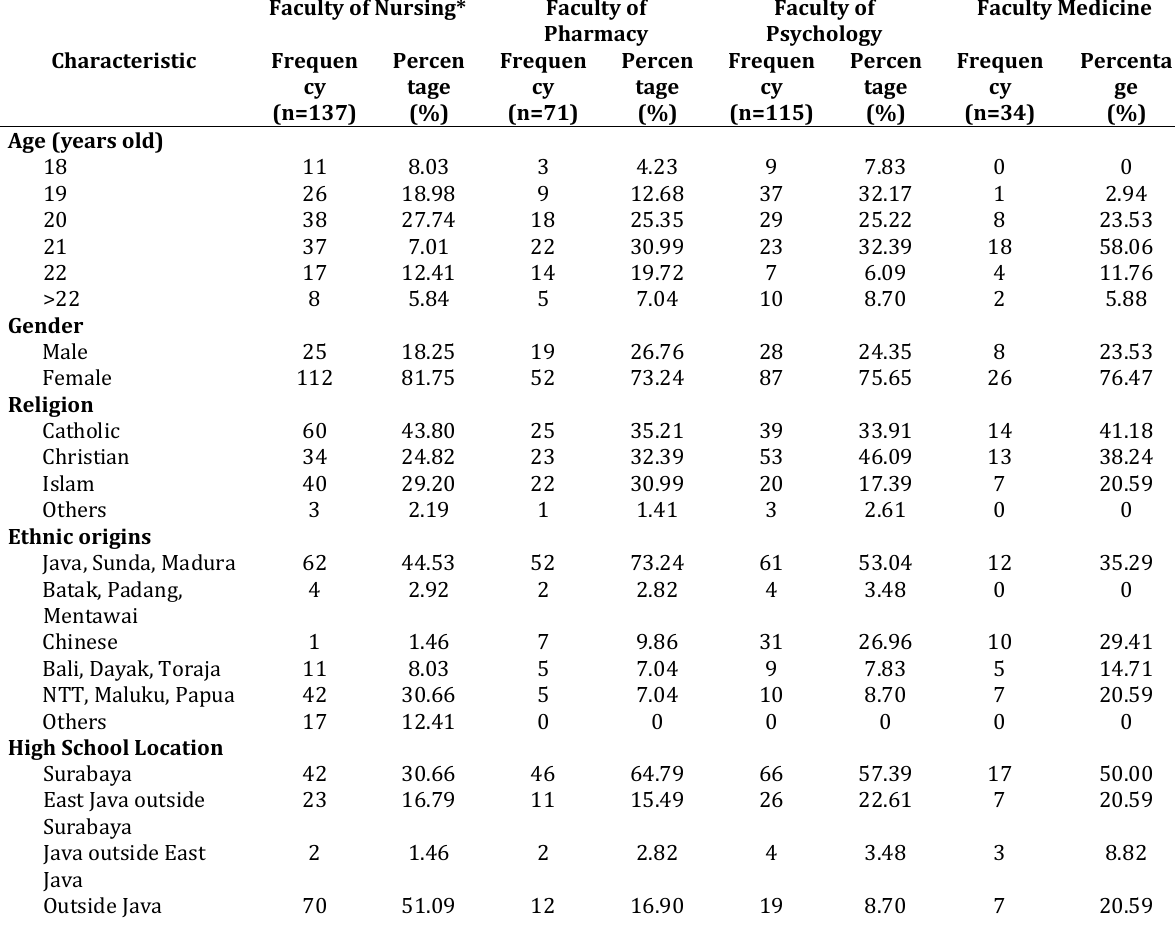
Table 1. Demography characteristic (n = 357)